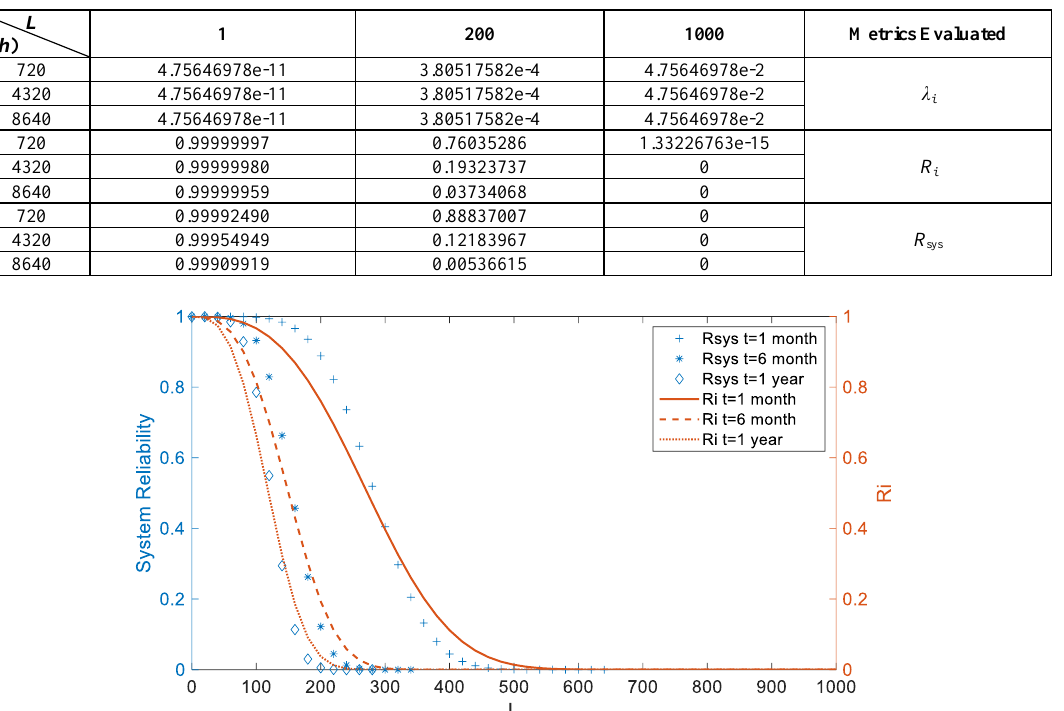
Table 9. Switch failure ( λ i ) rate and reliability ( R i ), and SAN reliability ( R sys ) at α i = 3.